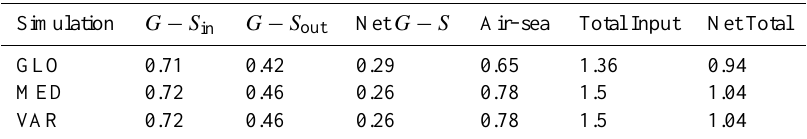
Table 3. Budget of anthropogenic carbon accumulated in the Mediterranean Sea (PgC) between 1800 and 2001. The budget distinguishes Strait of Gibraltar inflow ( G − S in ) via the AW, the corresponding outflow ( G − S out ) via the MOW, and the air–sea flux (Air–sea). Critical combined terms are thus the net inflow–outflow difference (Net G − S ), the total input ( G − S in + air–sea), and the net total (Net G − S + air–